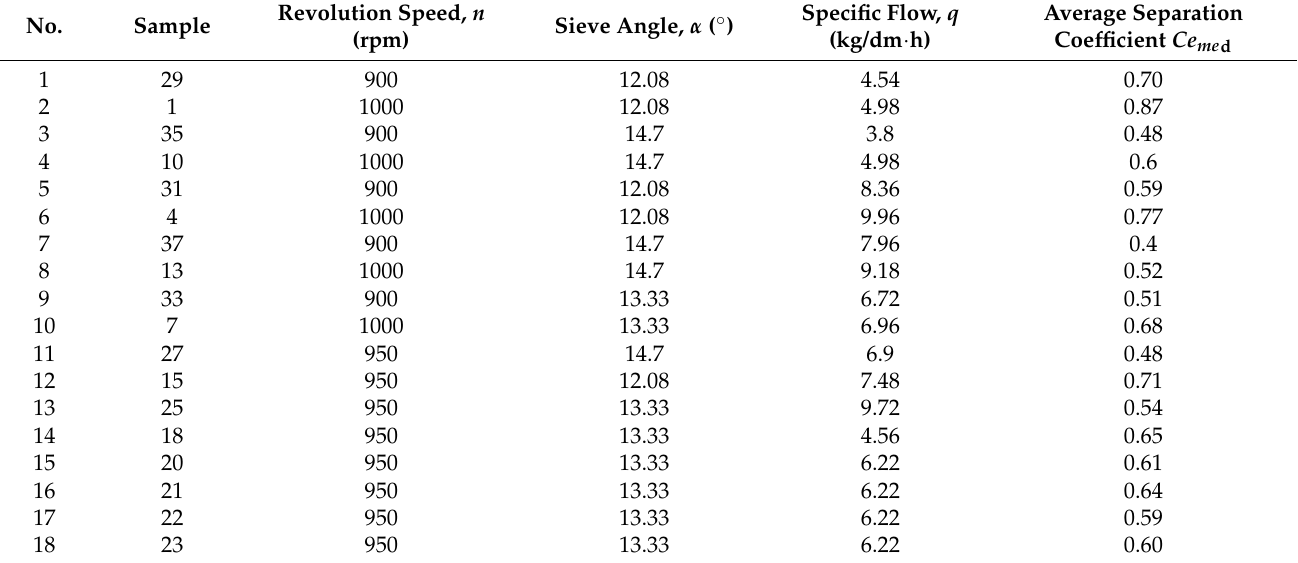
Table 4. Experimental program for average separation coefficient for nettle.